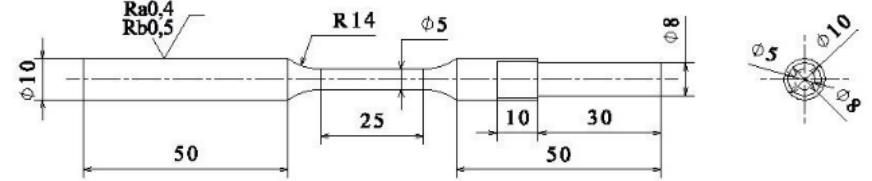
Figure 1: Used tensile samples for SSRT